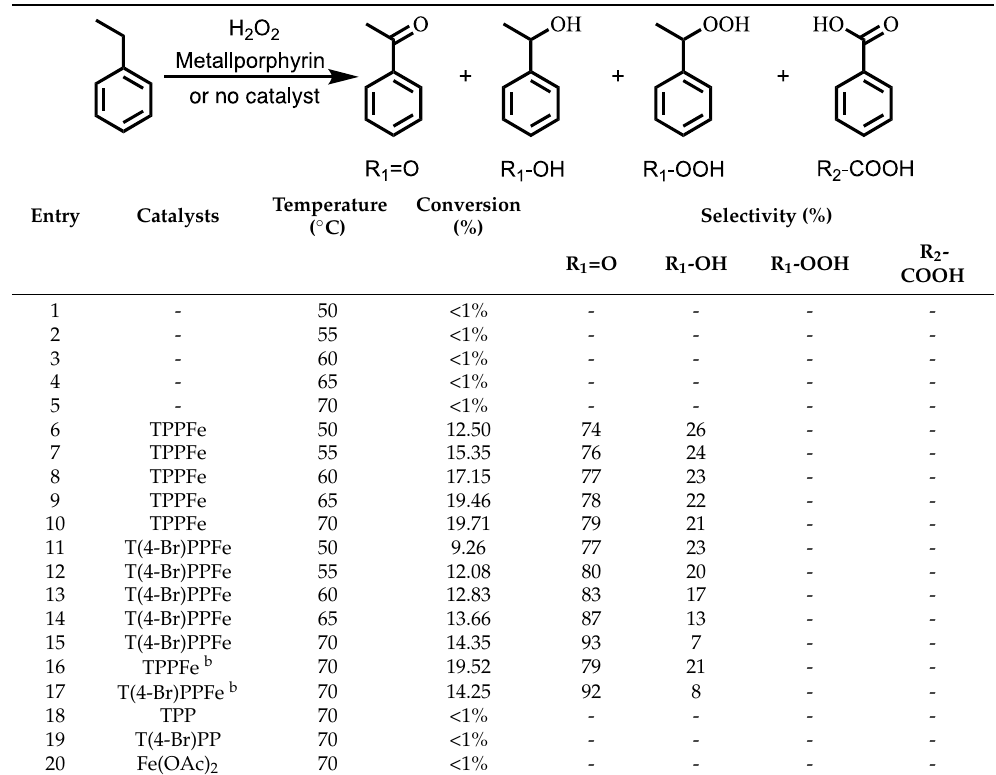
Table 1. Preliminary exploration on alkyl aromatics oxygenation temperature employing ethylben- zene as model substrate a .